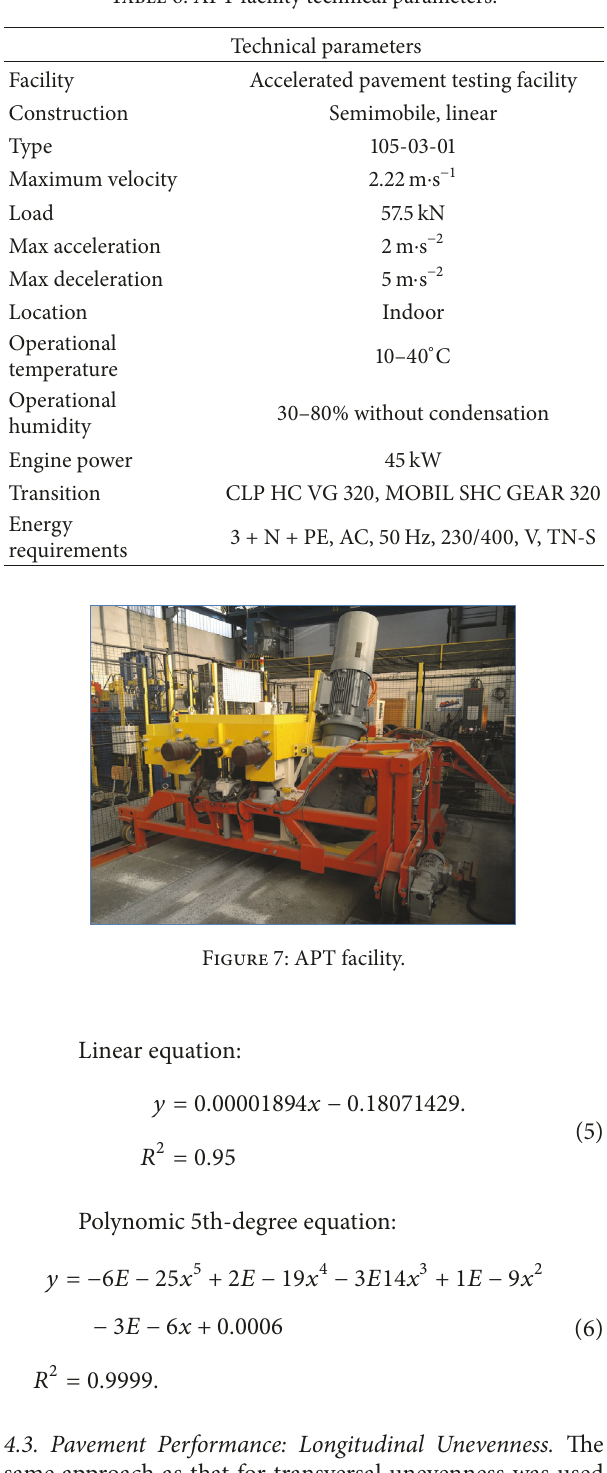
Table 6: APT facility technical parameters.